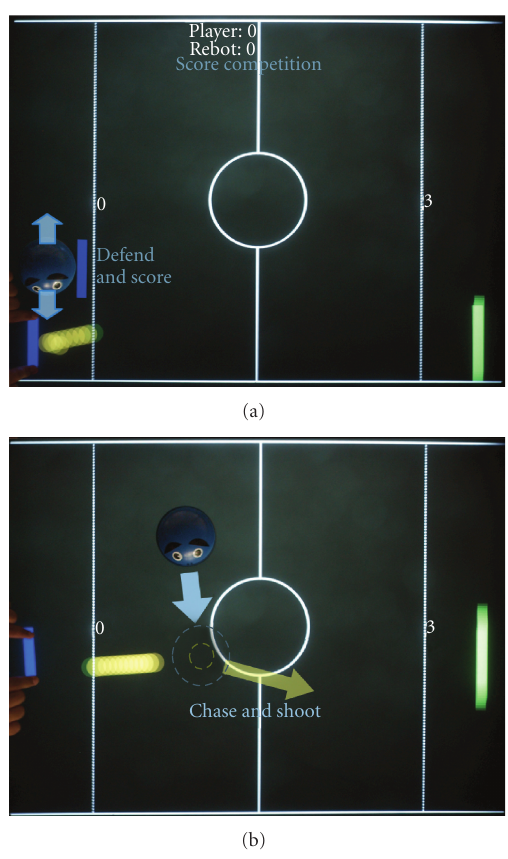
Figure 6: RoboPong game: competitive robot (a) and cooperative robot